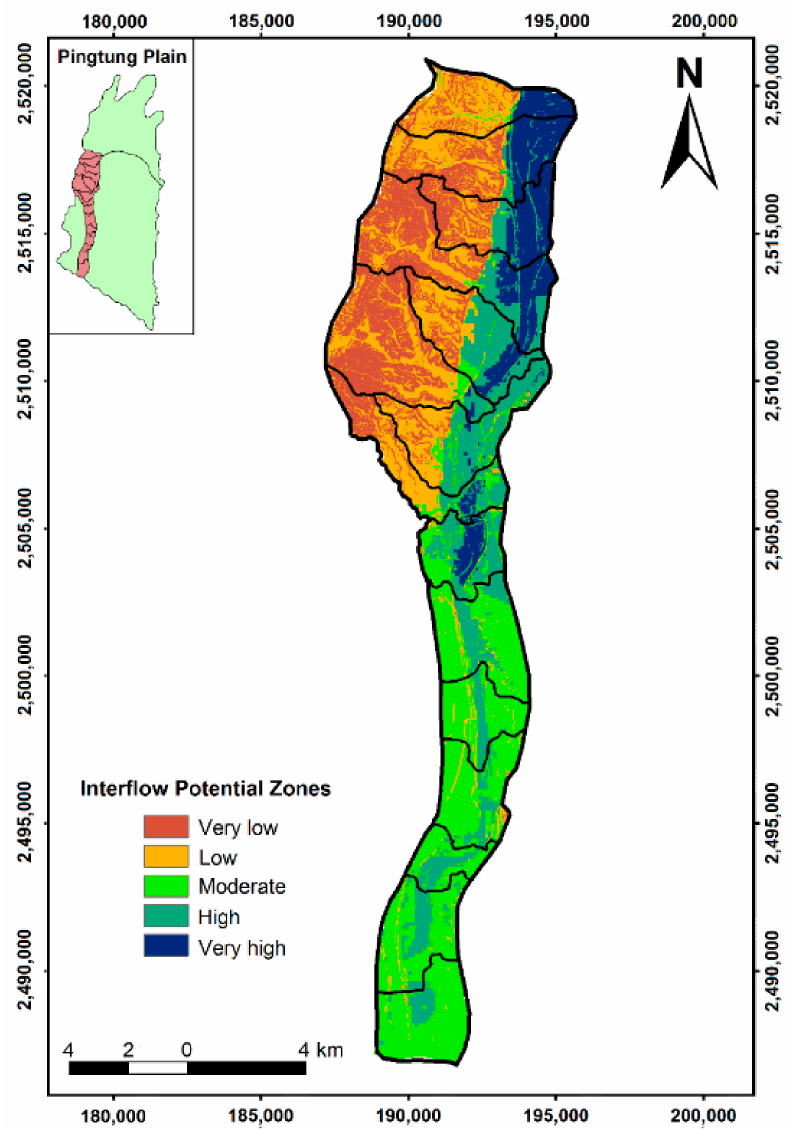
Figure 10. The modification of the interflow potential excluded the factor DD for the